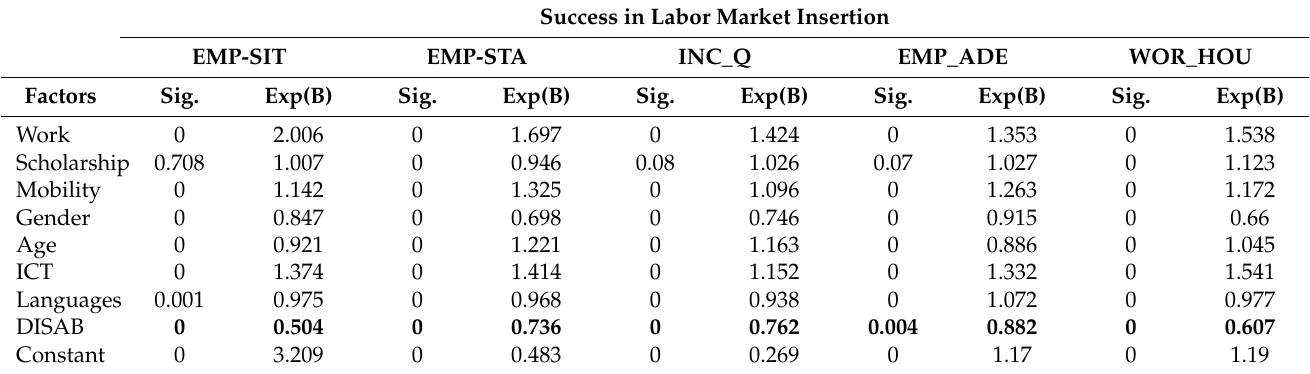
Table 2. Effect of disability on the success of employment in